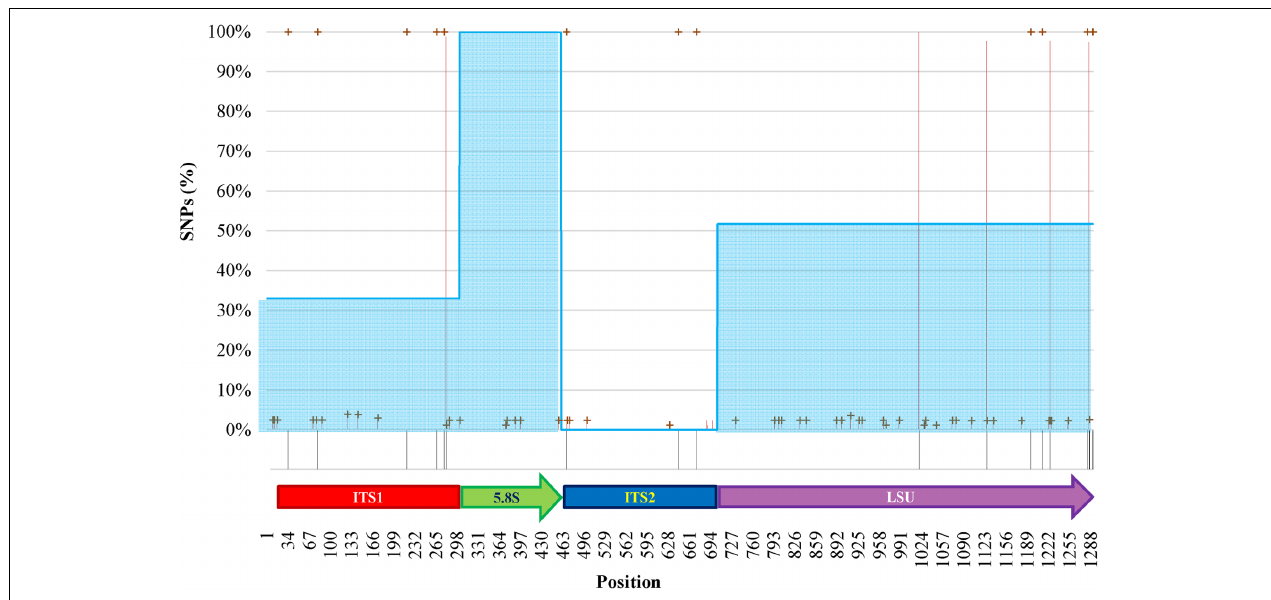
FIGURE 5 | SNPs analysis of clones of O. uvarum and O. philodendri type strain sequences. Black stripes below the abscissa represent variations between the two type strains. Red lines and green crosses represent the frequency of variants found among the clones when compared to O. uvarum and O. philodendri , respectively. Cyan areas indicate the average similarity of the clones to the O. philodendri type strains in the four